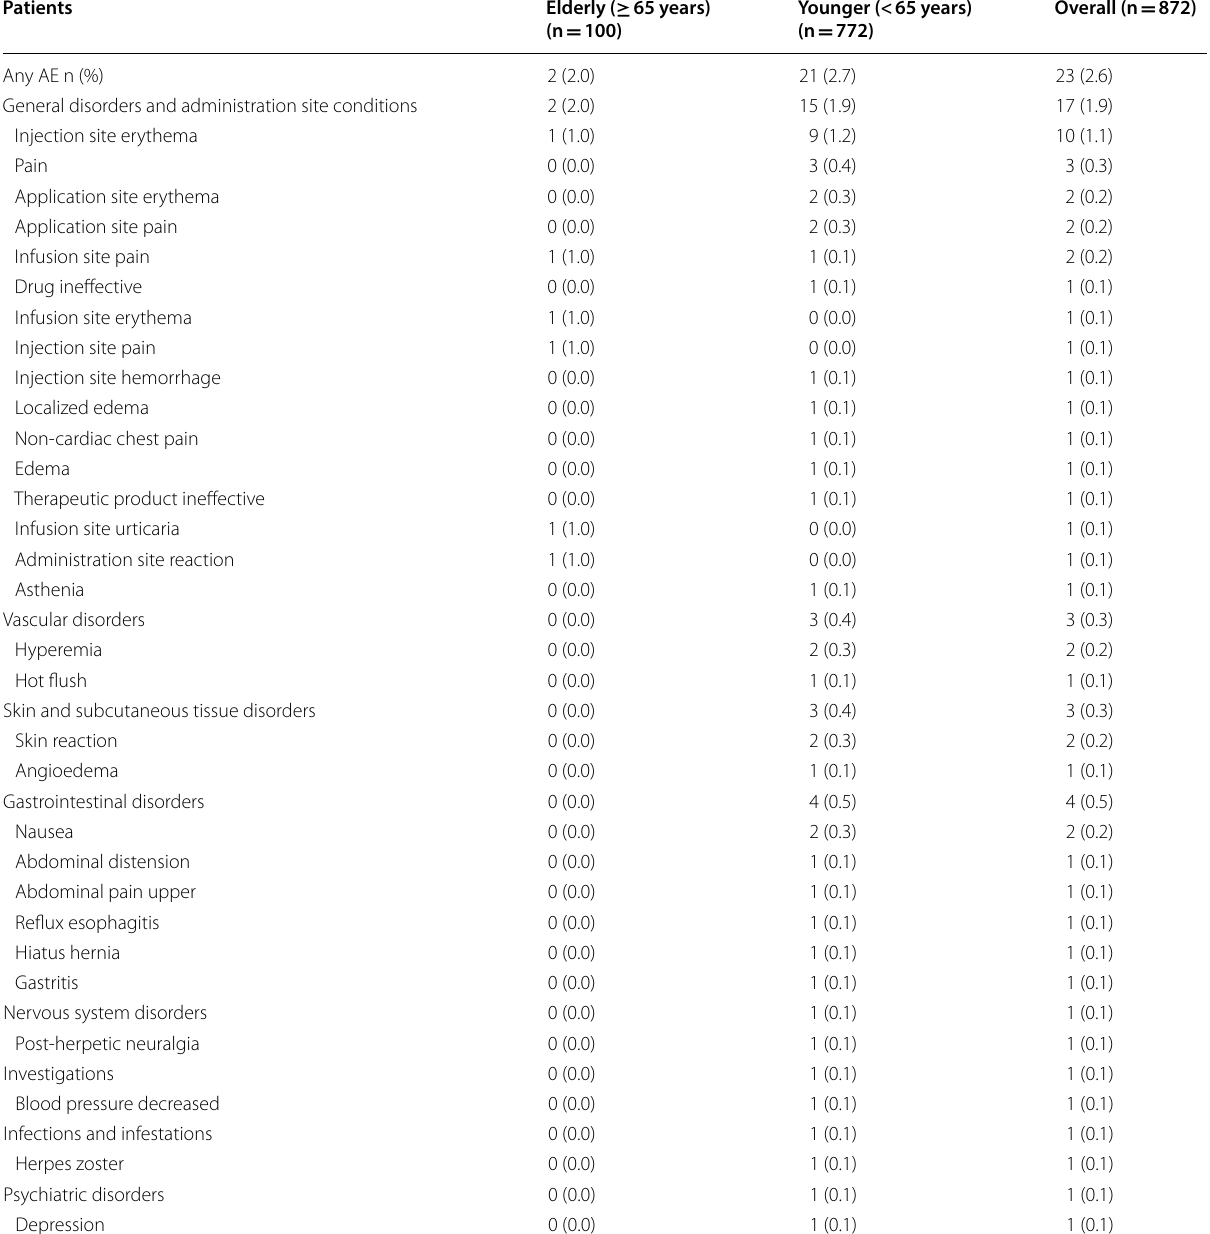
a Excludes AEs related to off-label use and pregnancy; AE adverse event